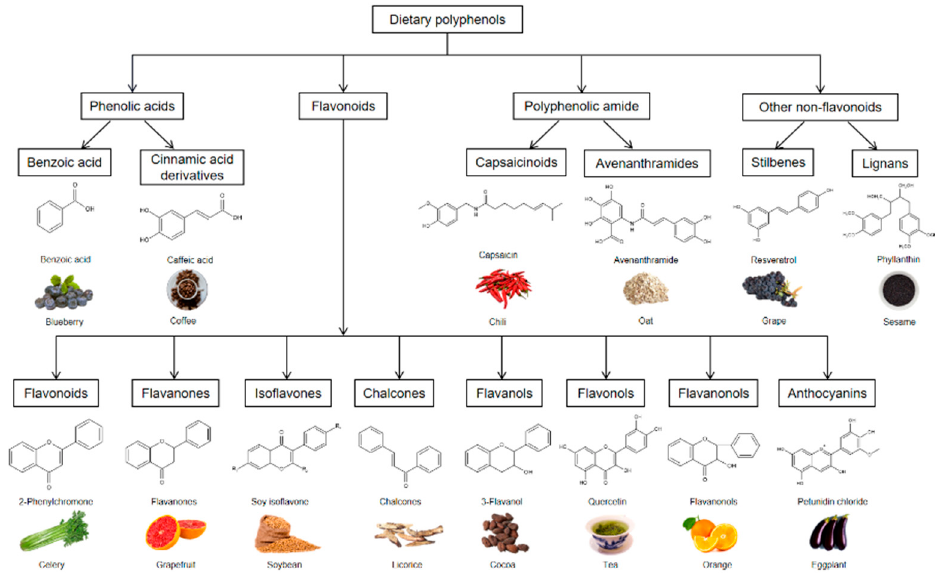
Figure 1. Classification of dietary polyphenols and their sources.